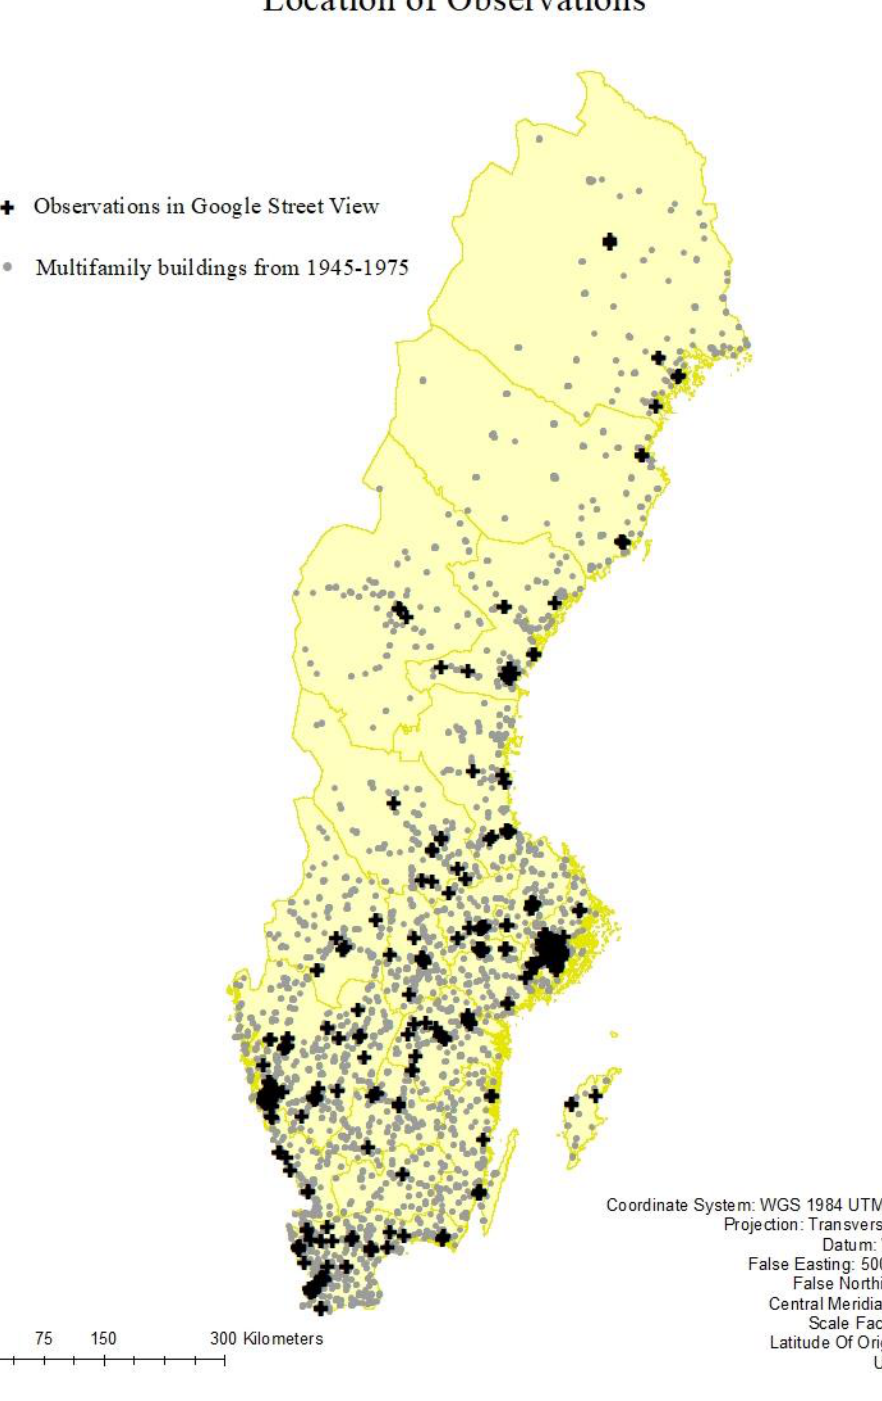
Figure 4. A map of Sweden showing the distribution of the multifamily building stock constructed between 1945 and 1975 (light dots) and the buildings that were observed in Google Street View (black crosses).